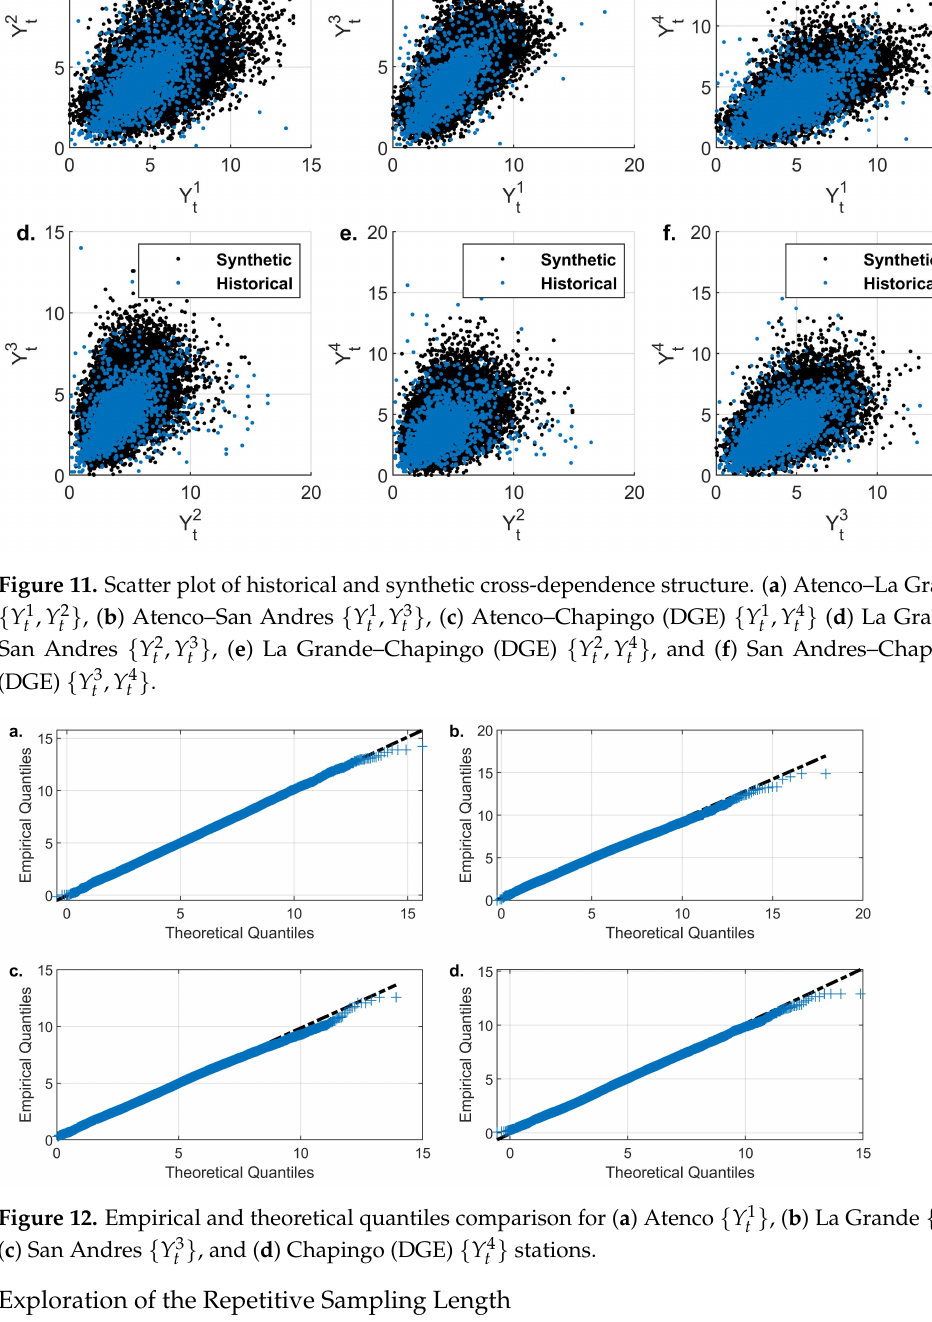
} , and ( d ) Chapingo (DGE) { Y 4 t